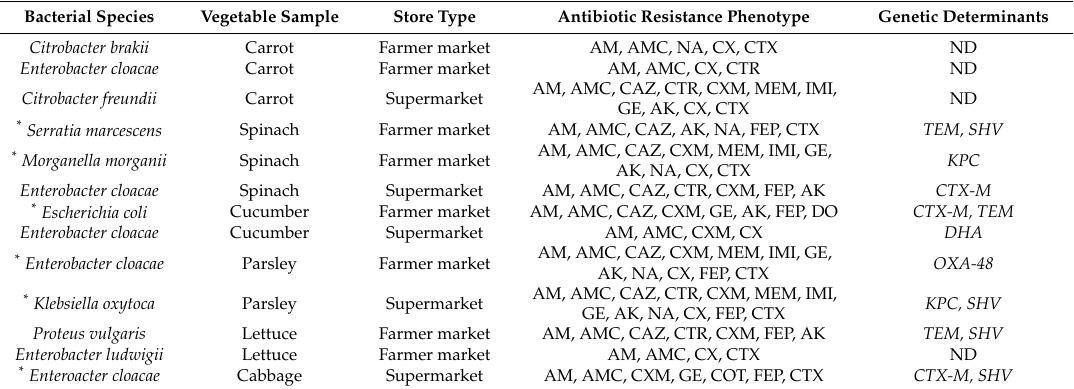
Table 3. Summaryofthebacterialspeciesisolatedfromdifferentfreshvegetables, indicating the phenotypic resistance profiles and the genetic determinants